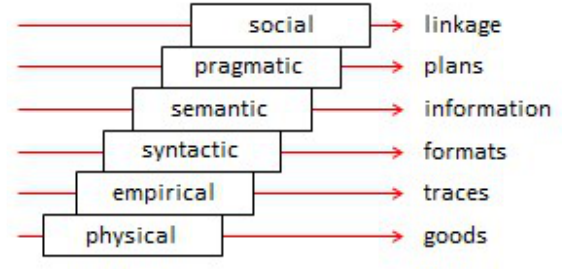
Fig. 20 exemplifies possible paths of influence of stakeholders